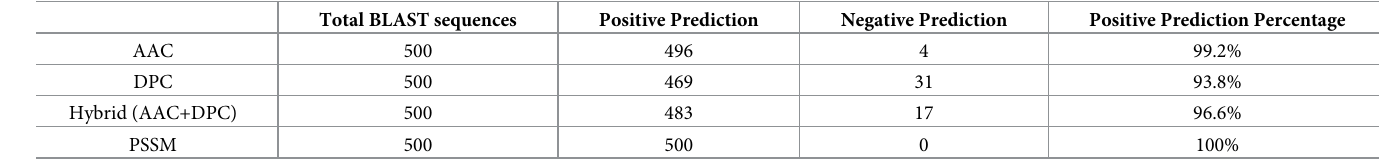
Table 3. The prediction performance of all models on the BLAST-Search